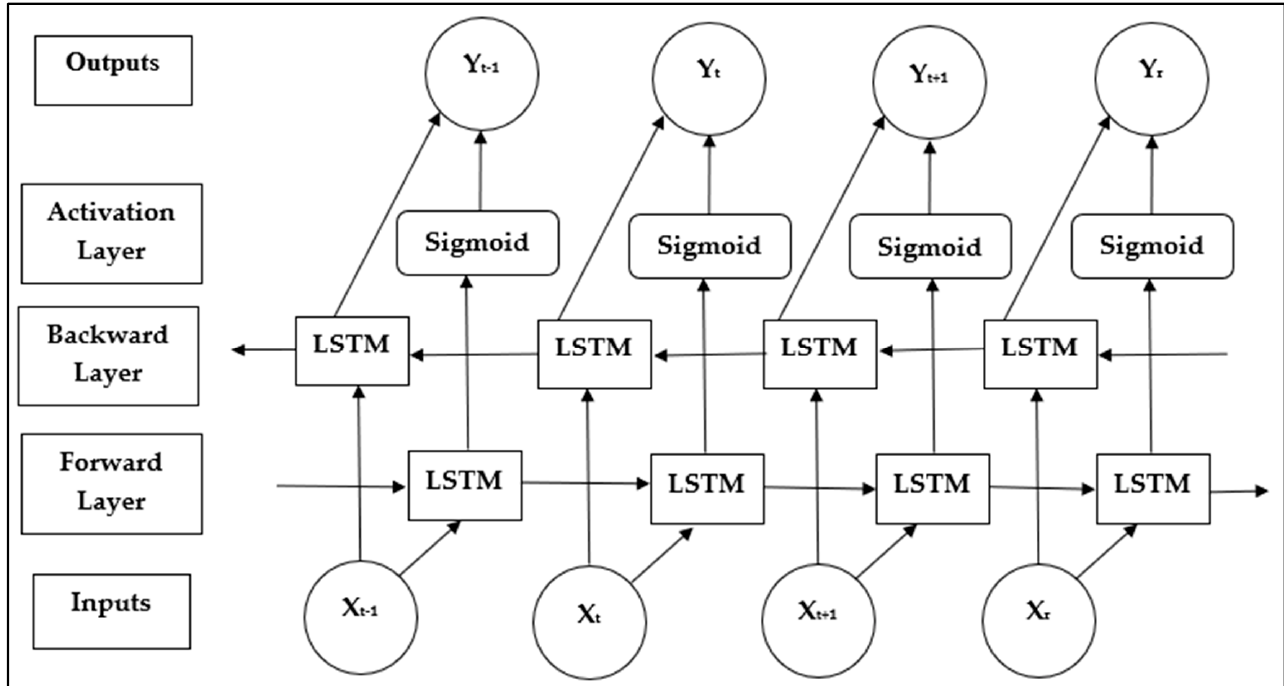
Figure 5. The process for the bidirectional LSTM layer [41]. The number of hidden units is 200. Having more hidden units increases the compu- tation cost without an improvement in the prediction accuracy, and also it increases the probability of overfitting [13]. The bidirectional LSTM layer is followed by a dropout layer, which minimizes the risk of overfitting [13], a fully connected layer is added with one predictor (percent of porosity), and the last layer is the regression